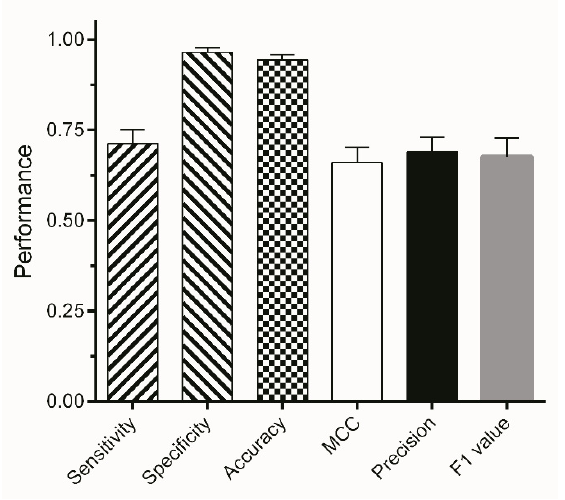
Figure 6. Mean performance metrics of segmentation on three different external test sets. Bars represent the mean value of TPR, TNR, ACC, MCC, PPV, and F1 of ETS1 ‐ 3 ± SD.